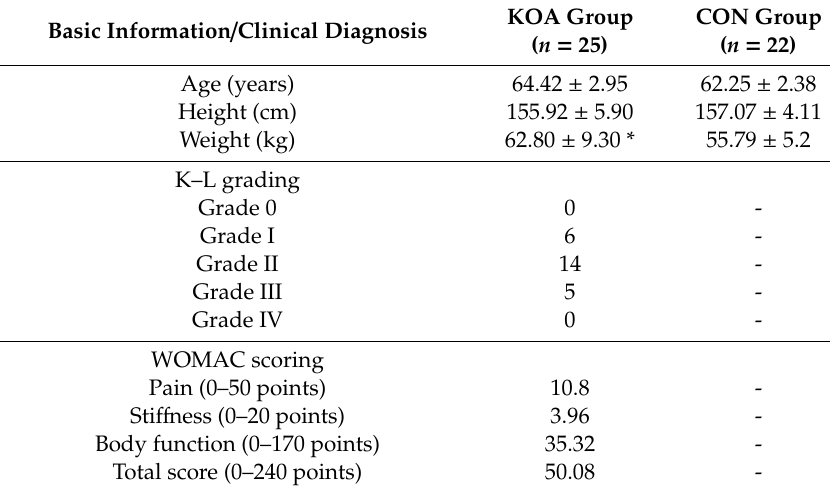
Table 2. Basic information and clinical diagnosis of